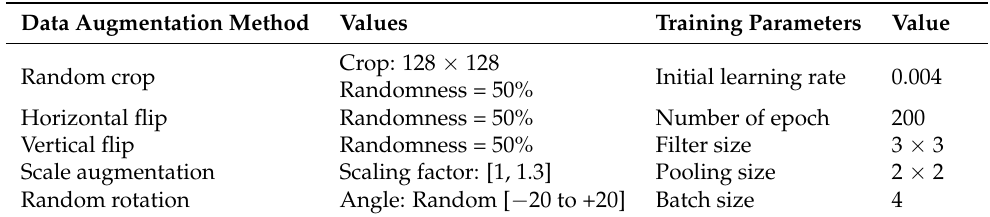
Table 2. Summary of data augmentation methods and training parameters for UNet, ResUNet, ResUNet++, and AB-ResUNet+ model